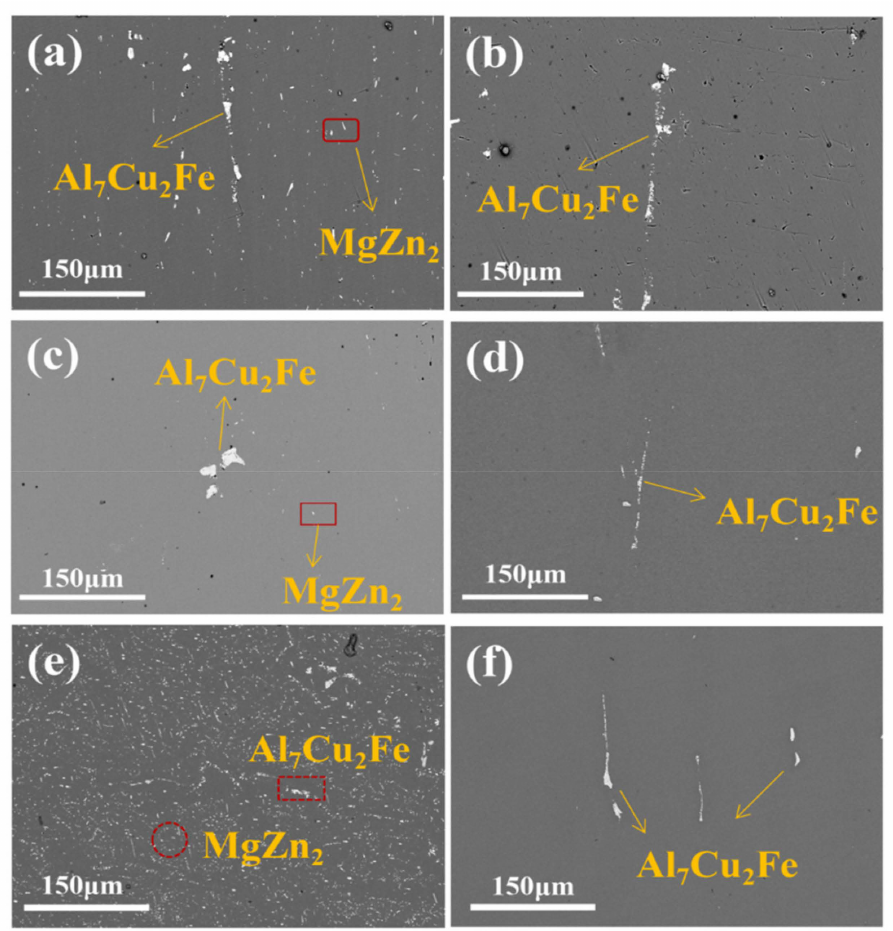
Figure 4. SEM figures of 25/65/120 mm hot rolled plates after solution at: ( a , c , e ) 477 ◦ C/30 min; ( b , d , f ) 477 ◦ C/90